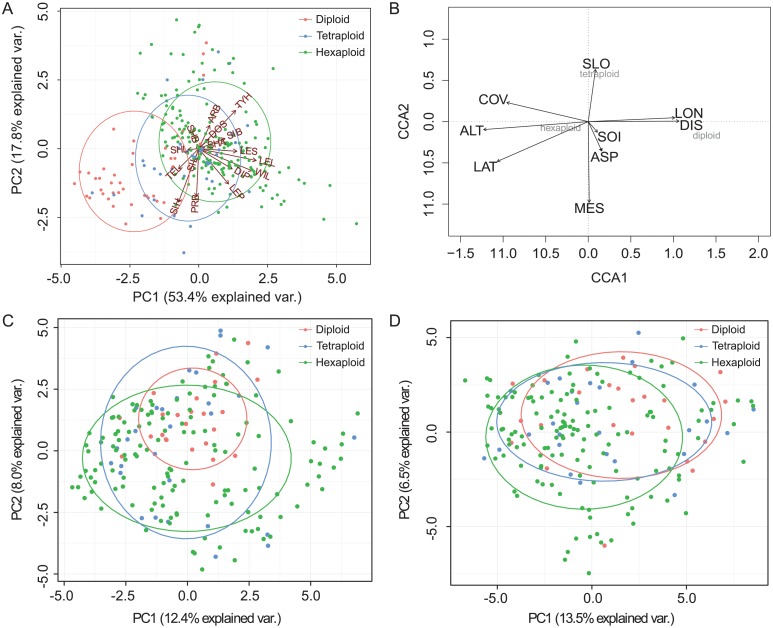
Principal components analysis (PCA) for morphological (a) and molecular variation (c: genetic; d: epigenetic), and (b) canonical correspondence analysis (CCA) for environmental variables and cytotype distribution of Actinidia chinensis.PCAs (a, c and d) only present the first two principal components and ellipses represent the dispersion of those points around their center. Abbreviations in PCA analysis of morphological variation are given in S2 Table and abbreviations in CCA analysis are given in Table 1.